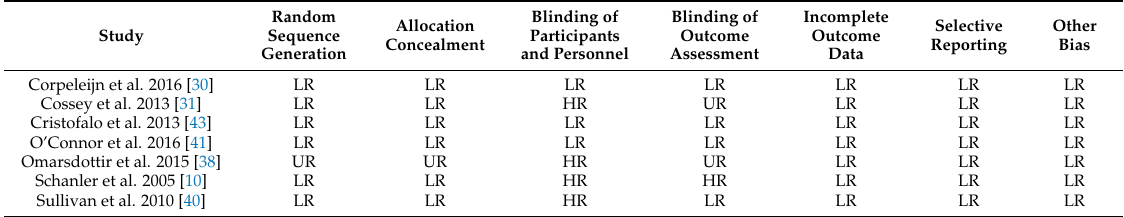
Table A1. Assessment of risk of bias of included randomized controlled trials.